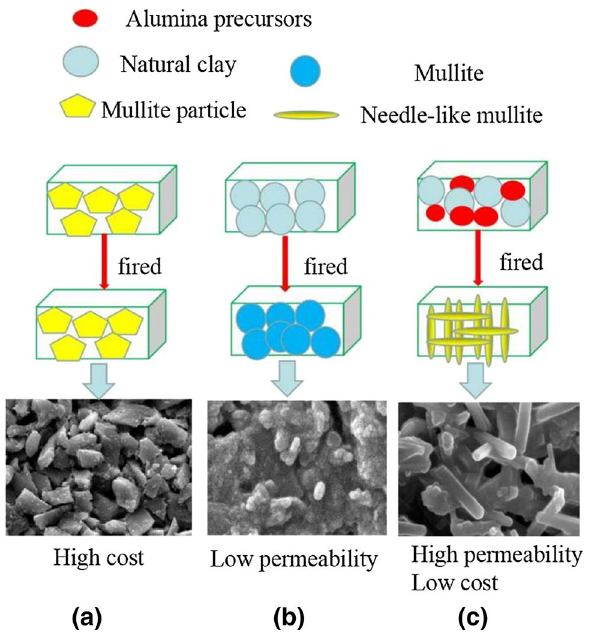
Fig. 1 Schematic diagram of preparation of porous mullite support with different processing